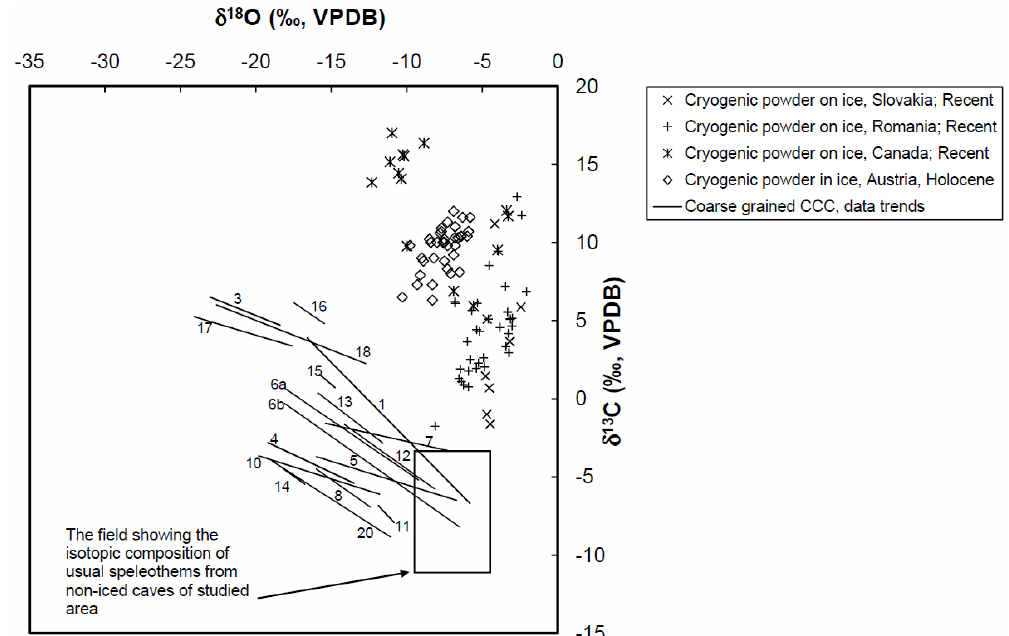
Fig. 1. Stable isotope data of CCC. Data for different localities of coarsely crystalline CCC are shown as trend lines, calculated using linear regression. The regression lines were calculated for all analyses available from a given locality (single crystal bulk analyses, single aggregate bulk analyses, point analyses center to rim in larger crystals and crystal aggregates). The trends are directed towards lower δ 18 O and higher δ 13 C values as freezing proceeds. Locality numbers are identical with those in Fig. 1 and Table S1 in the Supplement (Localities 2, 9, and 19 are not covered by published stable isotope data). Data sources: 1 – Apostelh¨ohle, Germany (Richter et al., 2010b); 3 – Glaseish¨ohle, Germany (Richter et al., 2009c); 4 – Großen Sunderner H¨ohle, Germany (Richter et al., 2009a); 5 – Heilenbecker H¨ohle, Germany (Richter et al., 2008, 2009b); 6a – Herbstlabyrinth, Germany, R¨atselhalle (Richter et al., 2010a), 6b – the same cave, Weihnachtsbaumhalle (Richter et al., 2011); 7 – Malachitdom Cave, Germany (Richter and Niggemann, 2005; Richter and Riechelmann, 2008); 8 – Ostenberg H¨ohle, Germany (Richter and Niggemann, 2005); 10 – BUML Cave, Czech Republic (ˇZ´ak et al., 2004); 11 – Javoˇr´ıˇcko Caves, Czech Republic (ˇZ´ak et al., 2011); 12 – Na Javorce Cave, Czech Republic (ˇZ´ak et al., 2011); 13 – Novoroˇcn´ı Cave (ˇZ´ak et al., 2011); 14 – Port´alov´a Cave, Czech Republic (ˇZ´ak et al., 2011); 15 – Haˇcova Cave, Slovakia (ˇZ´ak et al., 2011); 16 – Mesaˇcn´y tieˇn Cave, Slovakia (ˇZ´ak et al., 2011); 17 – Stratensk´a Cave, Slovakia (ˇZ´ak et al., 2004); 18 – Cold Wind Cave, Slovakia (ˇZ´ak et al., 2009); 20 – Jama Chelosiowa–Jaskinia Jaworznicka, Poland (ˇZ´ak et al., 2004). The data for fine-grained CCC, i.e. the cryogenic cave powder, are shown for comparison. Fine-grained CCC